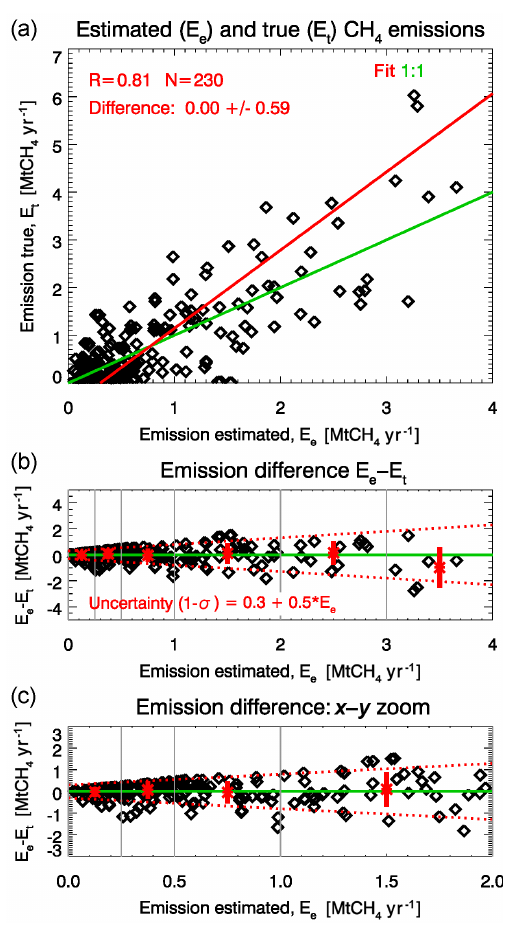
Figure 6. (a) “True” (i.e. CAMS) emission, E t , versus estimated emissions, E e , as obtained from the simulation-based assessment results shown in Figs. 4 and 5 (i.e. shown are all “hotspot cells” also shown in these two figures; see caption Fig. 4 and main text for details). (b, c) Emission difference “estimated minus true” ver- sus estimated emission. The grey vertical bars denote the bound- aries of emission bins for which mean differences (red crosses) and standard deviations of the differences (red vertical lines) have been computed. The red dotted line shows that the relationship between the estimated emission ( E e ) and its 1 σ uncertainty ( σ) can be ap- proximately described by σ ( E e ) = 0.3 + 0.5 E e .